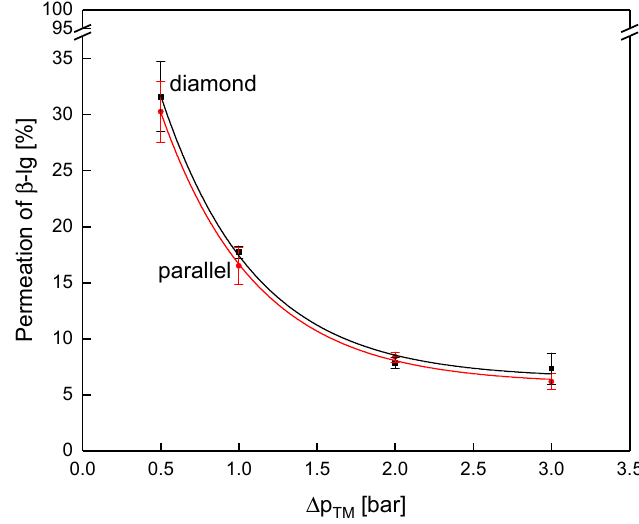
Figure 11. Permeation of β -lg as a function of the transmembrane pressure for the parallel and the diamond spacer during MF of concentrated skim milk (CF 3). Error bars represent the standard deviation of two individual experiments.